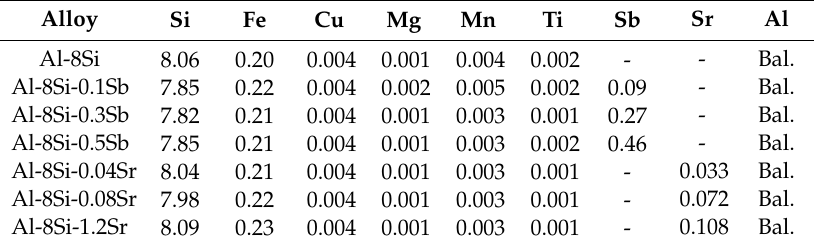
Table 1. Chemical compositions of Al-8Si alloys